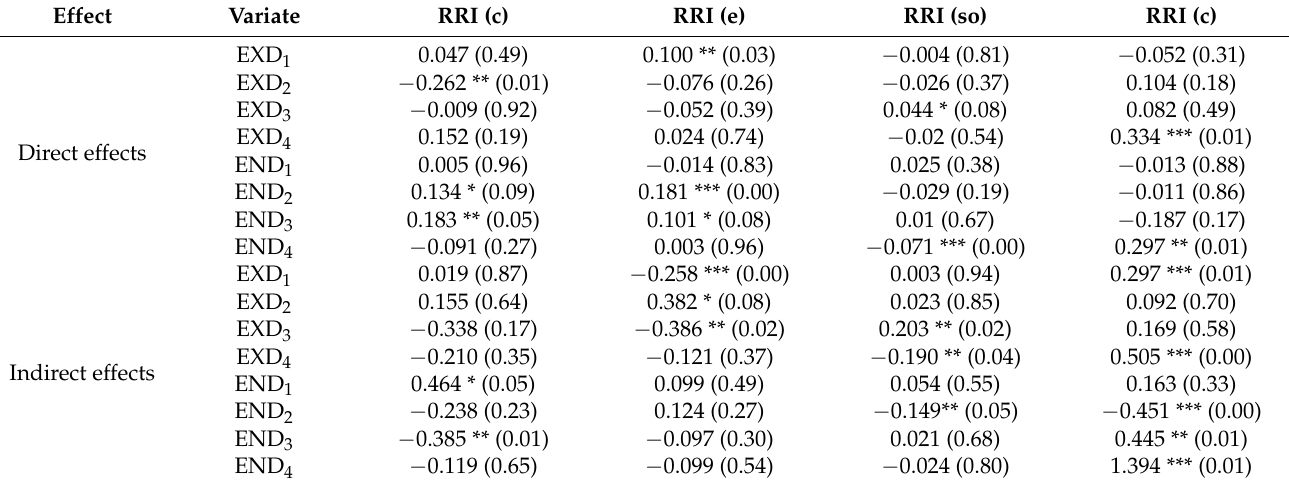
Table 4. Estimation of direct and indirect effects of the driving